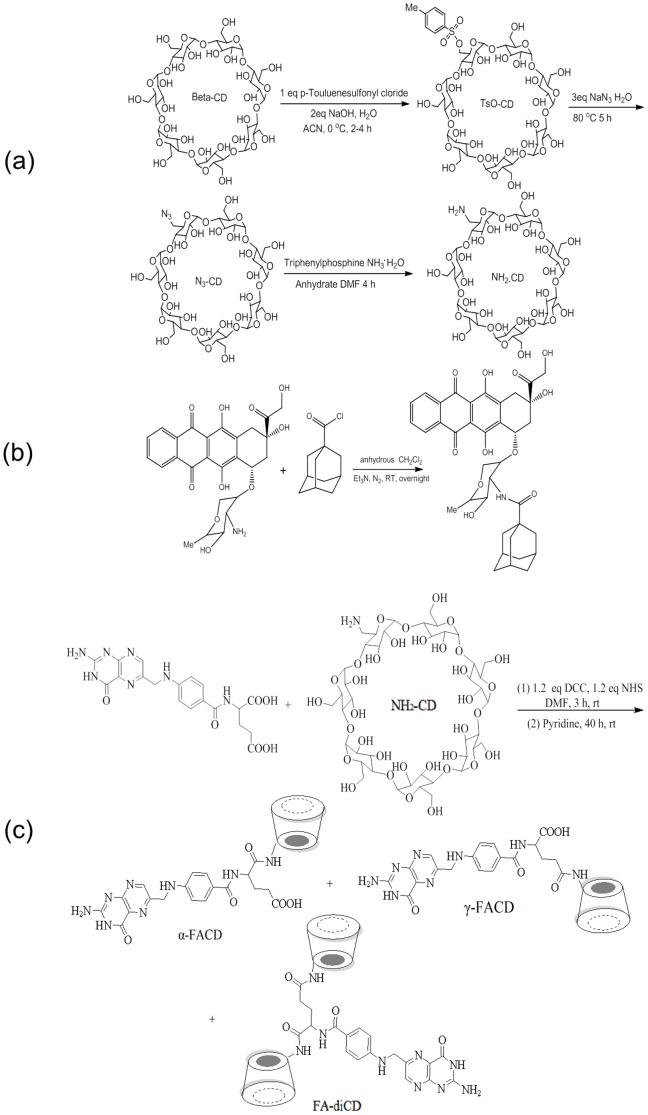
The reaction schemes to generate Ada-Dox (a), NH2-CD (b), and FACDs (c).